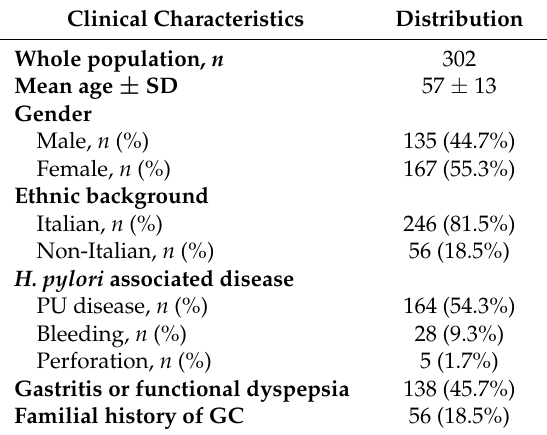
Table 1. Characteristics of the